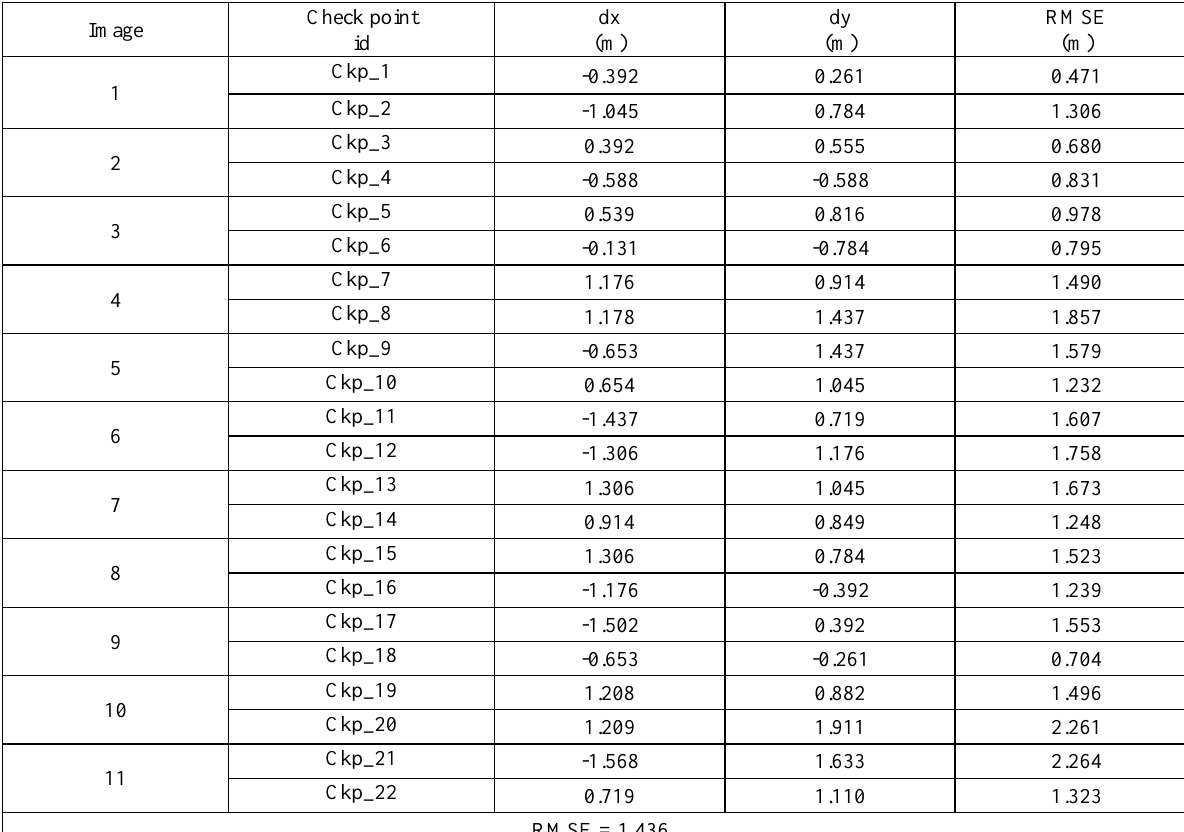
Table 3. Accuracy of check point(non-linear adjustment